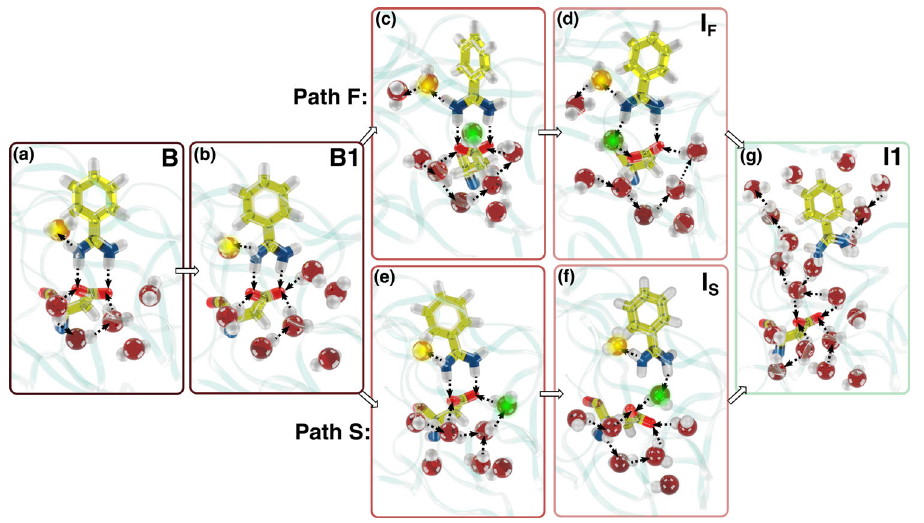
Fig. 5 | Two ligand unbinding mechanisms. Representative con fi gurations of states a B and b B1. c , e The pre-intermediate step of fast and slow mechanisms, respectively. d , f The intermediate step of the faster ( I F ) and the slower ( I S ) unbinding mechanisms. g Intermediate I 1 that presents a number of water